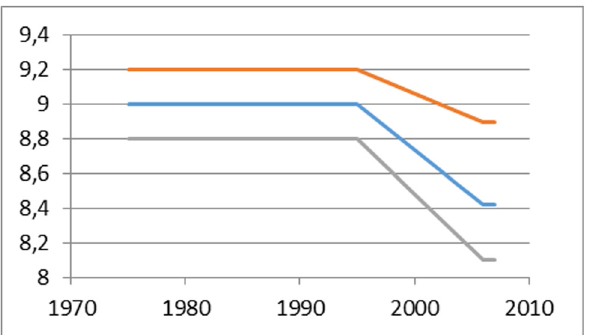
Figure 17: The progress of corrosion during the use of tank number 4 inventoried by the authors for the fi rst coating sheet ( maximum, average, and minimum values are compared here for illustrative purposes ) . Table 5: Changes in time of statistical parameters of experimentally